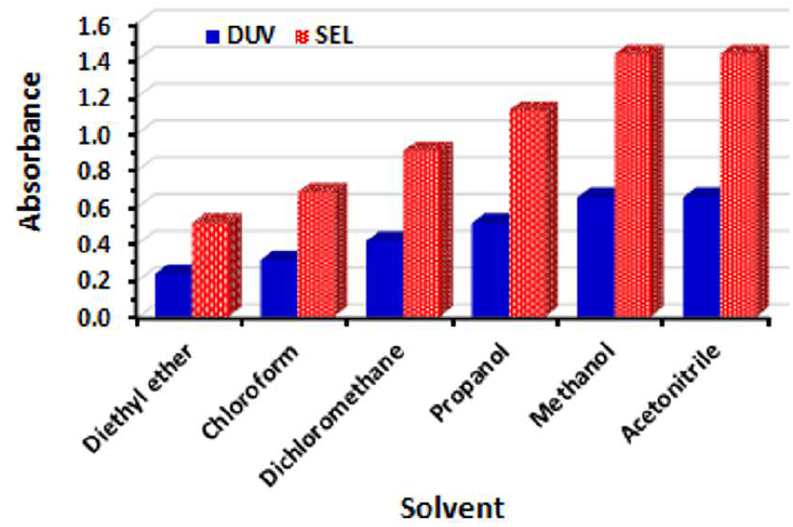
Figure 6. Effect of solvent on the reaction of DDQ (0.5%, w / v ) with DUV and SEL. Concentrations of DUV and SEL in their mixtures were 150 μg/well for both.